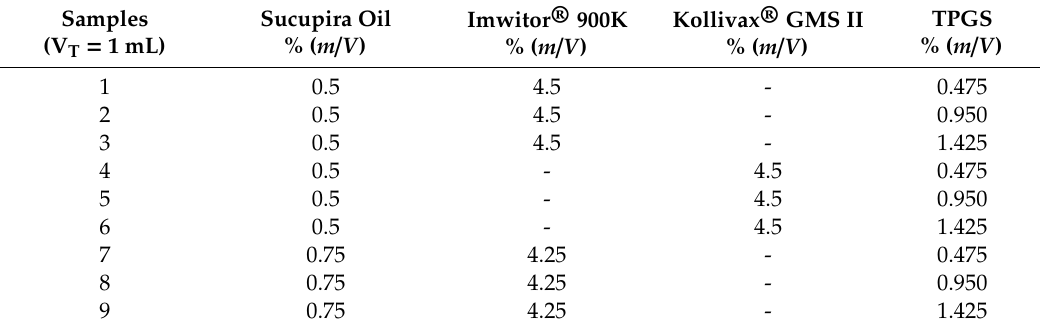
Table 2. Composition of sucupira oil-loaded nanostructured lipid carrier (NLC)